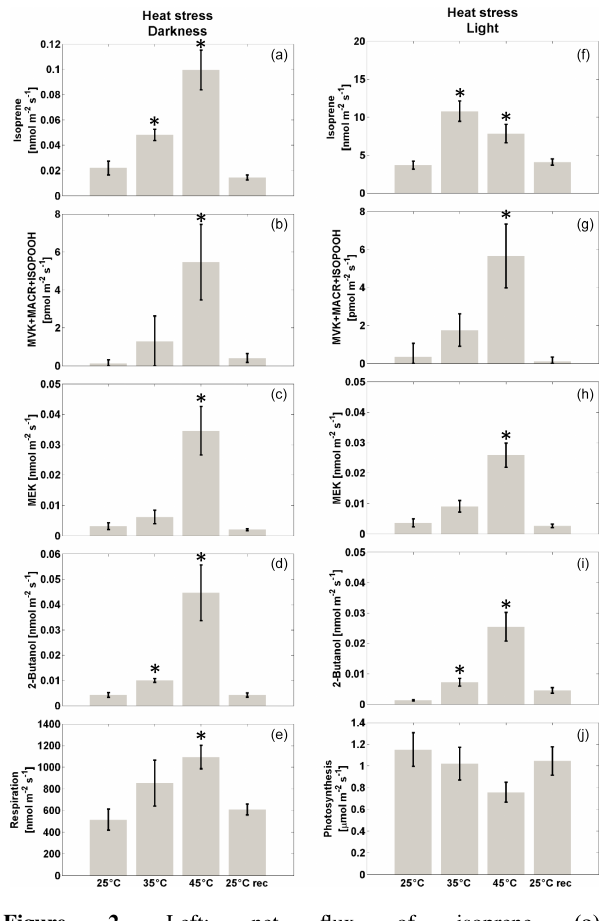
Figure 2. Left: net flux of isoprene (a) , MVK + MACR + ISOPOOH (b) , products from MVK reduc- tion (MEK, c , and 2-butanol, d ) and respiration (e) upon exposure to moderate (35 ◦ C) or severe (45 ◦ C) heat stress, and recov- ery to 25 ◦ C by red oak plants in the dark. The compound grouping is based on PTR-ToF-MS in H 3 O + mode. Results are reported as mean ± standard error ( n = 6). Asterisks indicate significant differences (Kruskal–Wallis, p < 0 . 05) compared to the unstressed (25 ◦ C) case. Right: emission of isoprene (f) , MVK + MACR + ISOPOOH (g) , products from MVK reduction (MEK, h , and 2-butanol, i ), and photosynthesis (j) upon exposure to moderate (35 ◦ C) or severe (45 ◦ C) heat stress, and recovery to 25 ◦ C in red oak plants in the light (ca. 90µmolm − 2 s − 1 light intensity). The compound grouping is based on PTR-ToF-MS in H 3 O + mode. Results are reported as mean ± standard error ( n = 6). Asterisks indicate significant differences (Kruskal–Wallis, p < 0 . 05) compared to the unstressed (25 ◦ C) control.